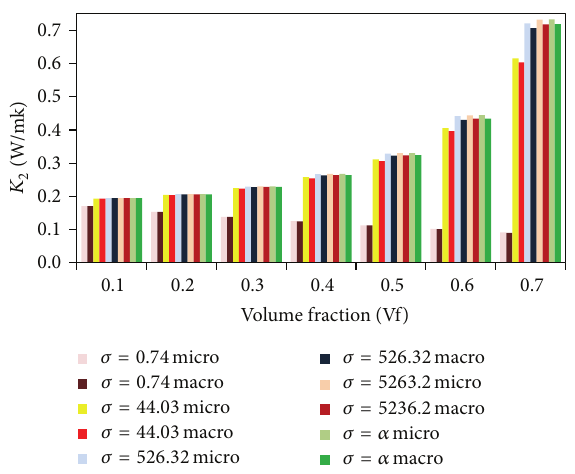
Figure 14: Variation in 𝐾 2 with respect to Vf of a composite with alternate layers of fibres fully debonded.